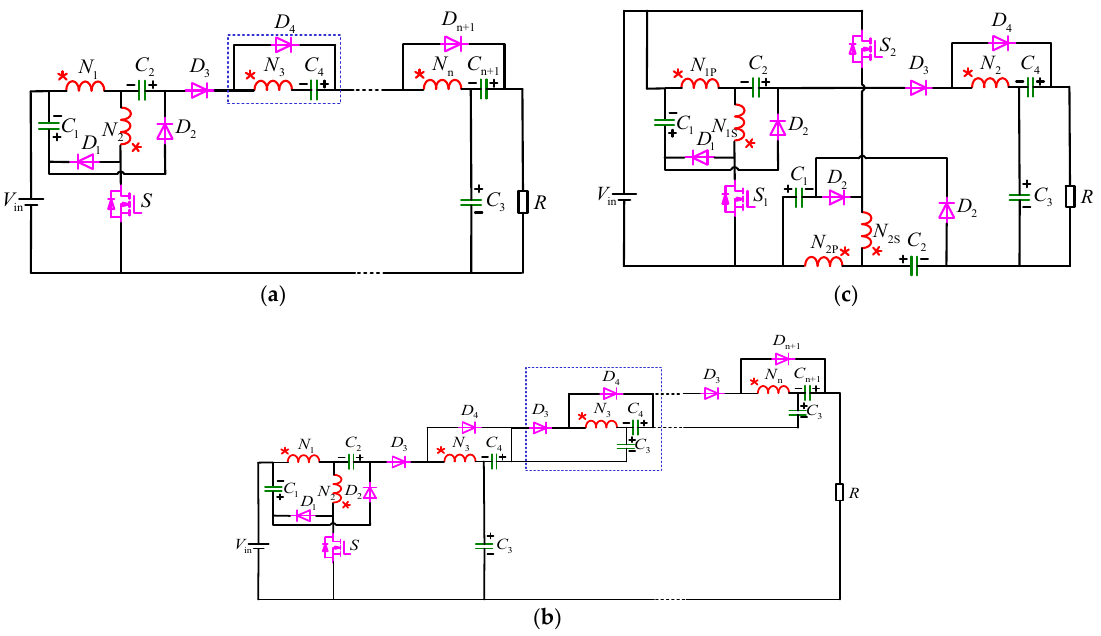
Figure 6. Derivative proposed converters. ( a ) Multiple winding coupled-inductor converter with series-connected voltage-lift networks (VLN); ( b ) multiple winding coupled-inductor converter with multiple windings coupled-inductor and multiple diode-capacitor networks; and ( c ) multiple winding coupled-inductor converter with input-parallel-output-series technique. Table 2. The component numbers and voltage gains of derived converters. Diode Number Capacitor Number